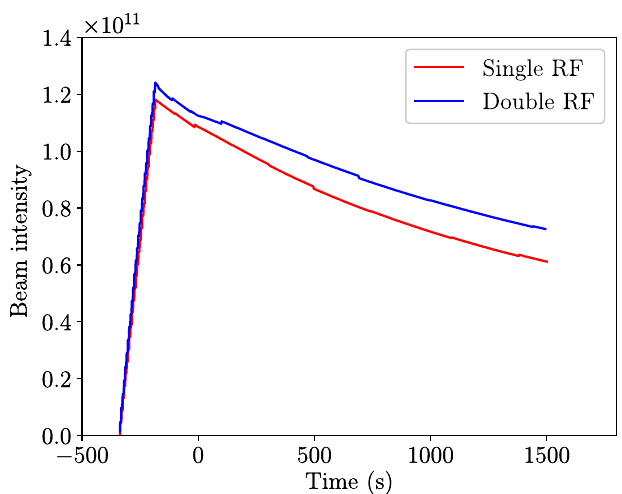
FIG. 9. Evolution of the bunched beam intensity with a single rf system (red trace) and with a double rf system (blue trace).